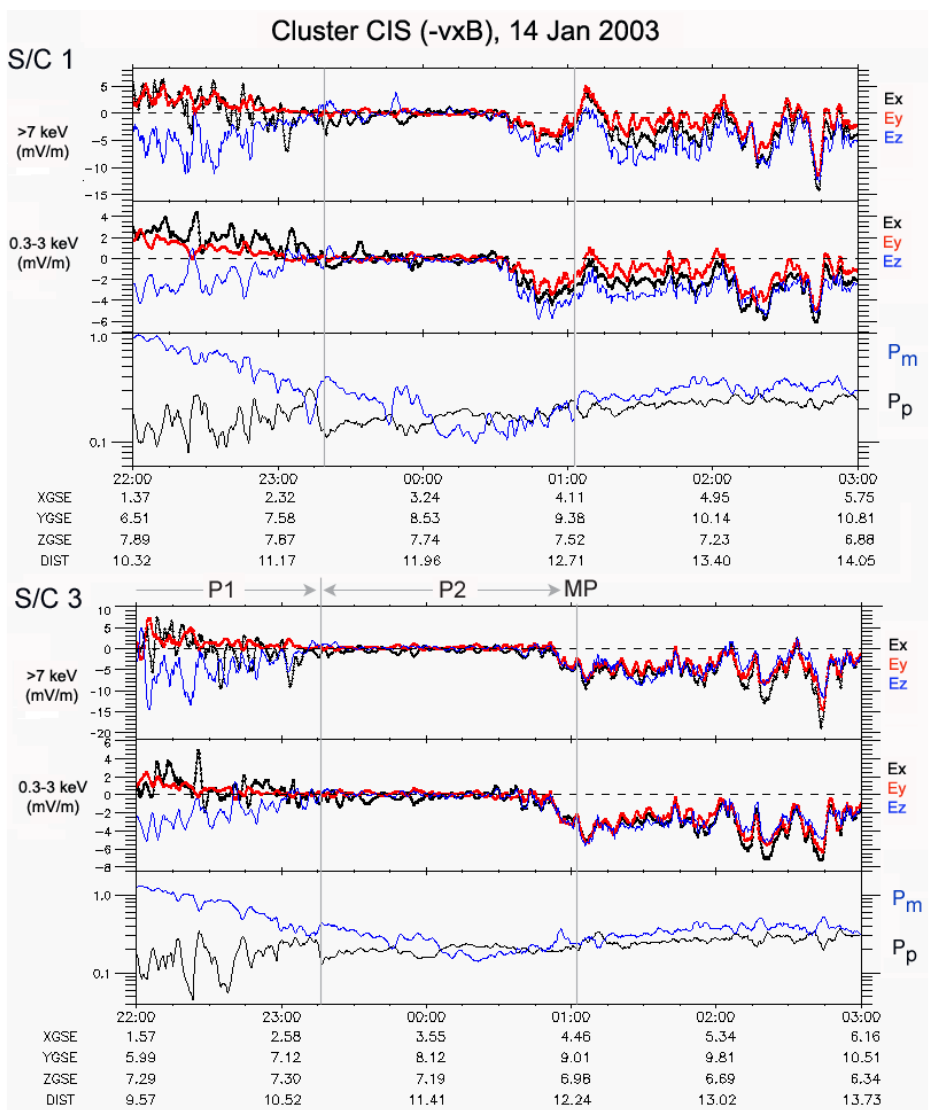
Fig. 4. − v × B and pressure for s/c 1 and s/c 3 on 14 January 2003. Top panels show − v × B in GSE coordinates for two energy intervals, > 7keV and 0.3–3keV. Bottom panel shows plasma pressure (Pp) and magnetic field pressure